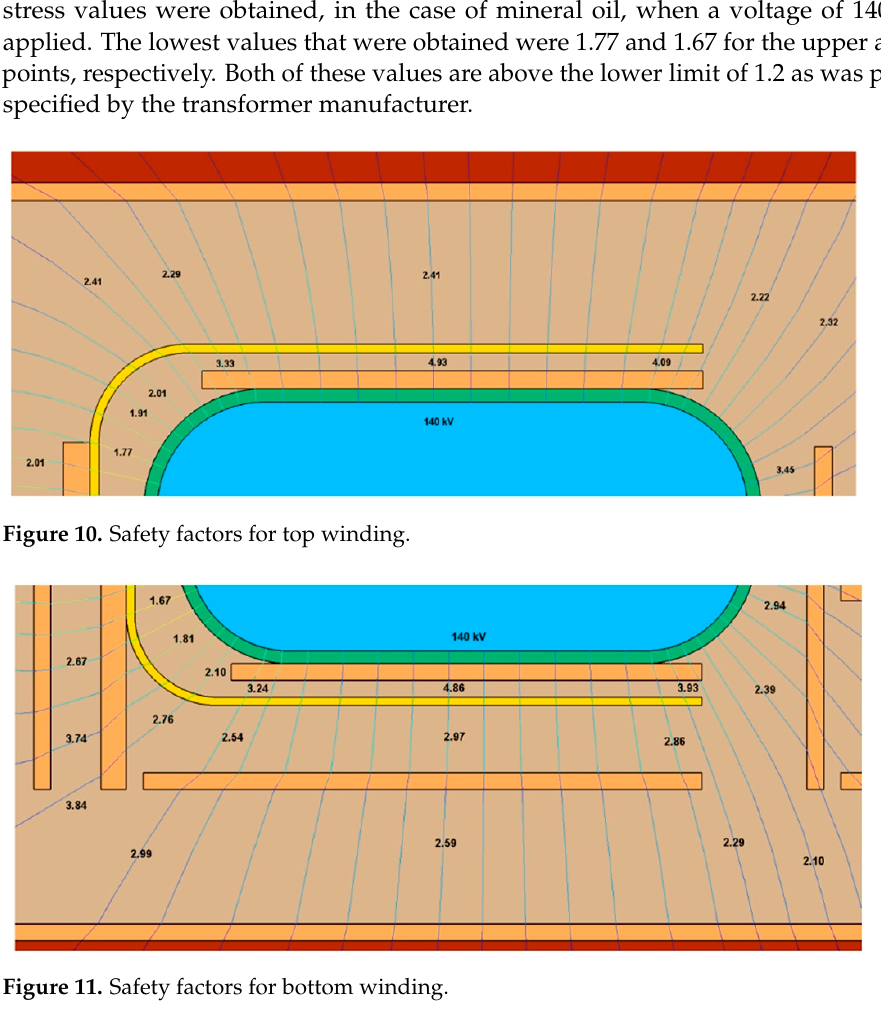
Figure 9. Electric field analysis points: (1) HV top and bottom winding; (2) HV to regulation windings; (3) HV to LV windings; (4) LV to core.